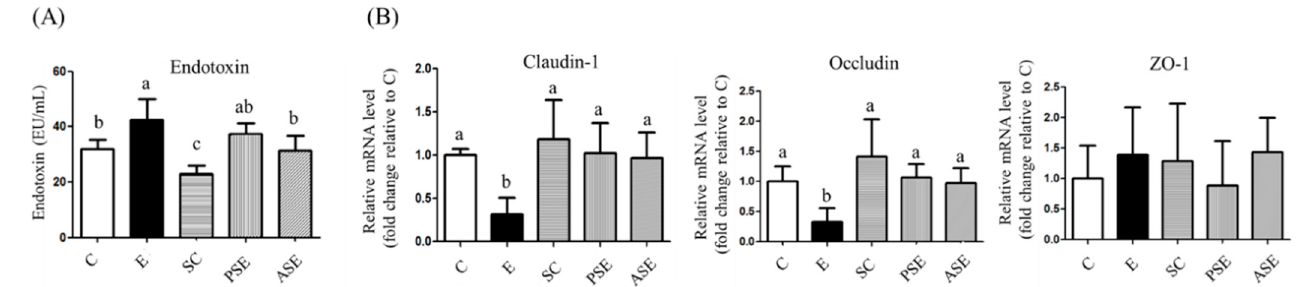
Figure 3. Effects of synbiotics on plasma endotoxin level and intestinal mRNA expressions of claudin-1, occludin, and zonula occludens (ZO)-1 in rats with chronic ethanol feeding. ( A ) Plasma endotoxin level. ( B ) Intestinal mRNA expressions of claudin-1, occludin, and zonula occludens (ZO)-1. β -Actin was used as an internal control. mRNA levels were calculated by the 2- ∆∆ CT method, and the ratio of each internal control was calculated by setting the value of the mean of the C group to 1. Bars are the mean ± standard deviation ( n = 6). Different letters indicate a significant difference at p < 0.05 by a one-way ANOVA with Duncan’s post-hoc test.